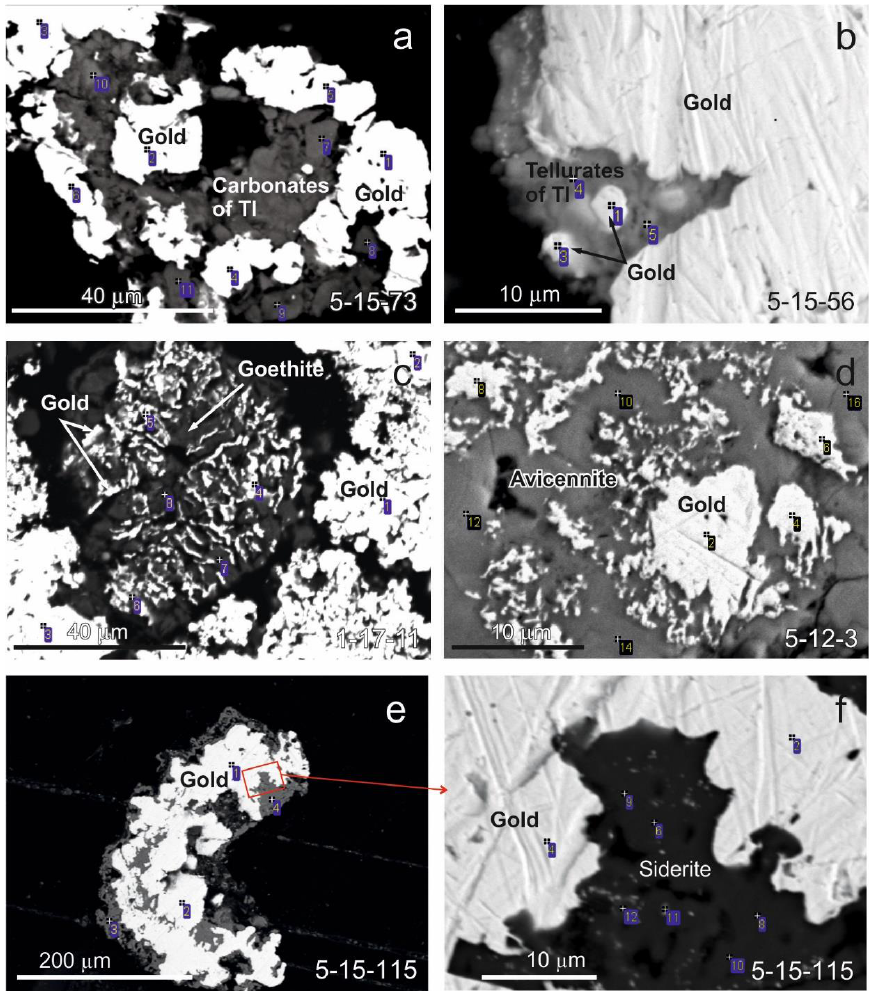
Figure 5. Massive gold in association with various supergene minerals. ( a ) massive gold in association with unnamed carbonates Te, Fe, Tl, ( b ) massive gold with inclusions of unnamed tellurates Tl, ( c ) honeycomb gold at the edges, sponge gold in the center in close association with goethite, ( d ) inclusion of massive and sponge gold in avicennite, ( e ) massive gold in association with siderite, ( f ) enlarged fragment of e. Mounted sections, scanning electron microscope, image in the back-scattering electron mode.